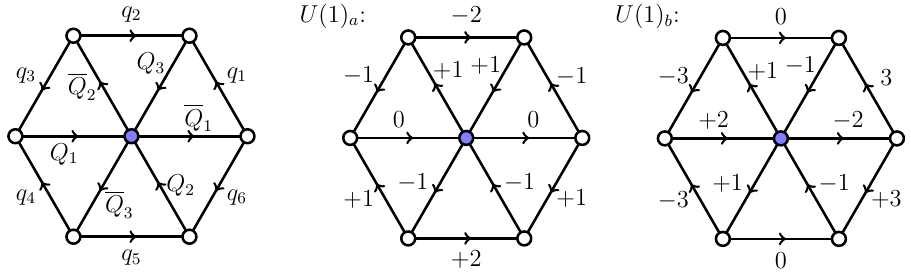
Figure 6 . In the left diagram we label the matter superfields associated with the unit cell according to figure 3. The SU(3 N ) and SU( N ) labels are suppressed, replaced by filled and open circles (respectively) at the nodes of the diagram. In the central and right diagrams we list the charges of the superfields under the U(1) a and U(1) b symmetries,